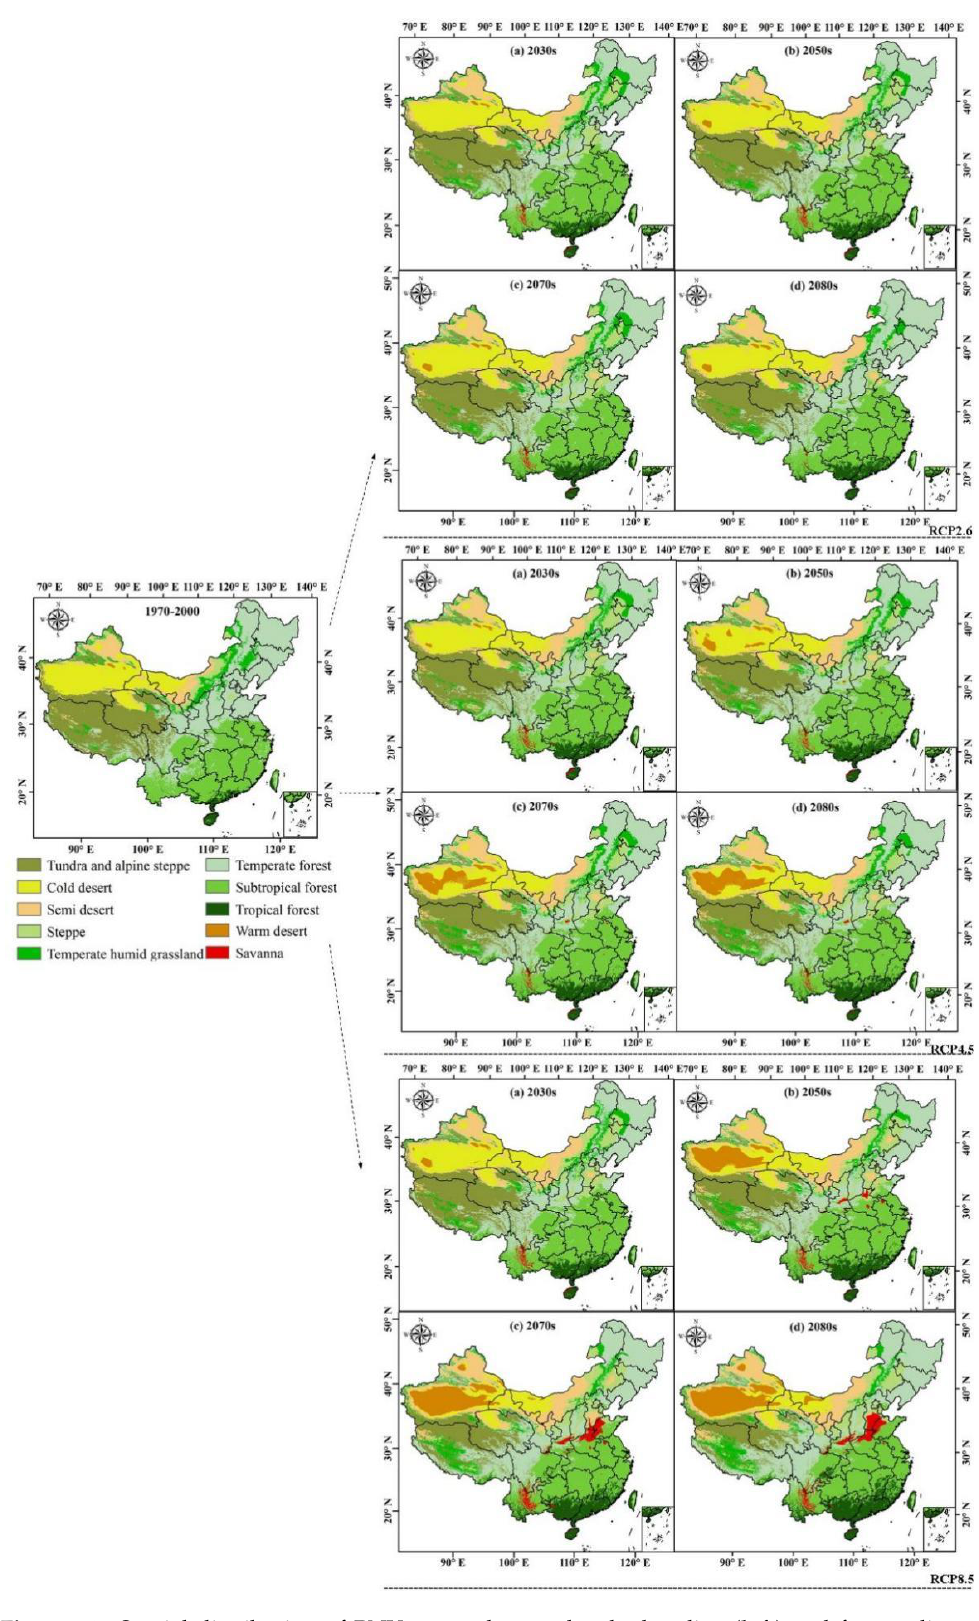
Figure 14. Spatial distribution of PNV super-class under the baseline ( left ) and future climate scenarios ( right ).